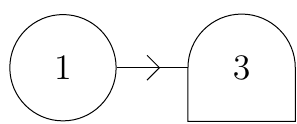
Figure 3 . The quiver corresponding to the surface operator